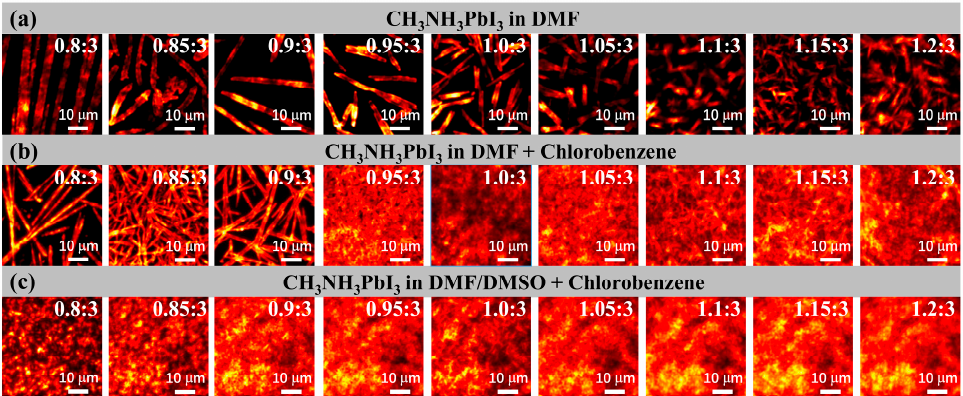
Figure 1. The PL morphology of films composed of different precursors, fabricated via different methods. ( a ) The image of CH 3 NH 3 PbI 3 films deposited by direct spin without any solvent dropping, and the precursors dissolved in DMF, ( b ) and ( c ) were spun with chlorobenzene dropping, and the precursors were separately dissolved in DMF and DMF/DMSO mixed solvent.